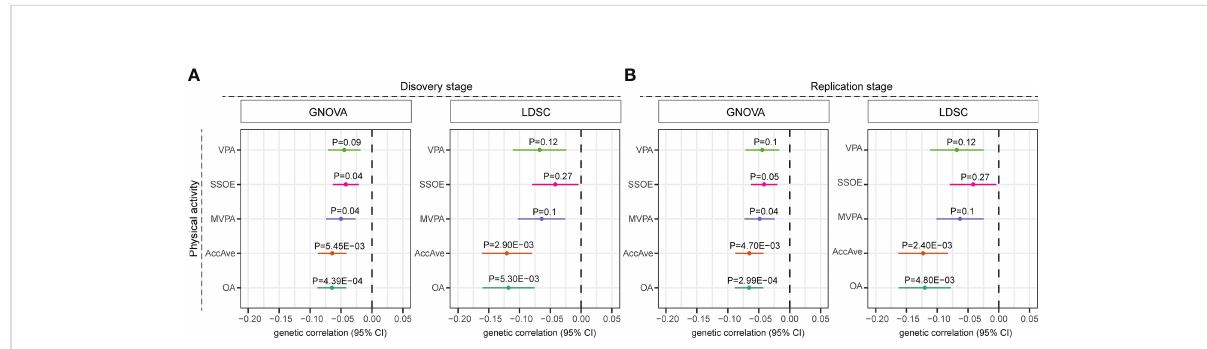
FIGURE 1 Genetic correlation between physical activity and multiple sclerosis. Genetic correlation was estimated using the GNOVA and LDSC methods in the (A) discovery and (B) replication stages. Error bars indicate 95% con fi dence intervals. AccAve, overall acceleration average; MVPA, self-reported moderate-to-vigorous physical activity; VPA, self-reported vigorous physical activity; SSOE, strenuous sports or other exercises; OA, overall